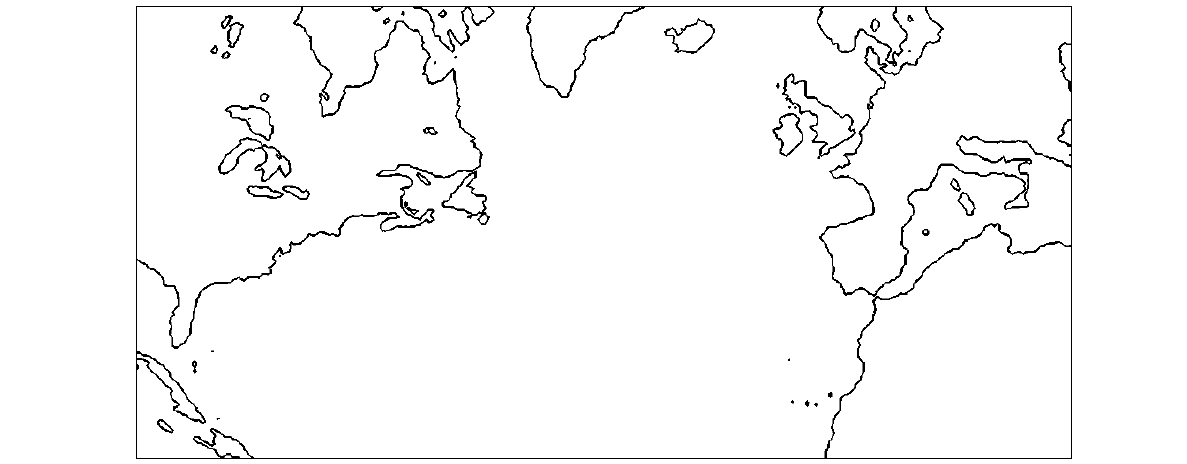
Figure 3. BOLAM domain.